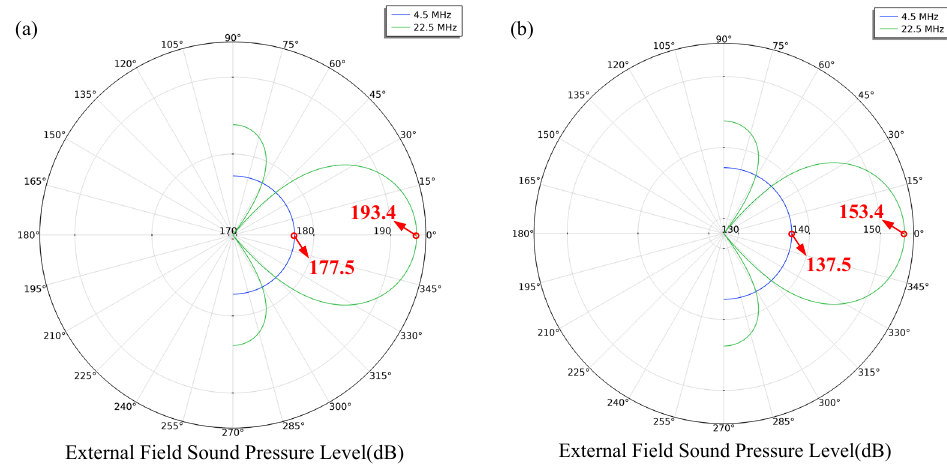
Figure 7. ( a ) Radiation pattern at an external field radius of 0.5 mm; ( b ) radiation pattern at an external field radius of 50 mm.